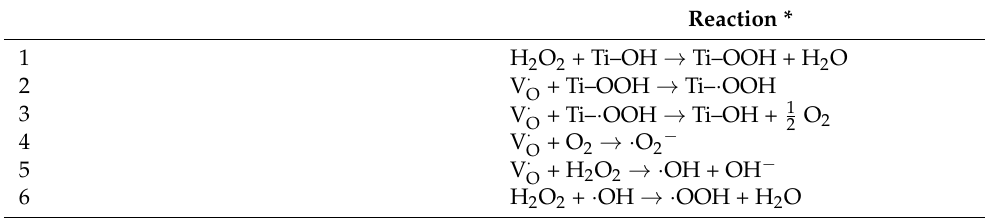
Table 3. Steps in the mechanism for the catalytic ROS generation in the dark. Activation of H 2 O 2 performed on TiO 2 with single-electron-trapped oxygen vacancies (SETOVs) is proposed in ref.